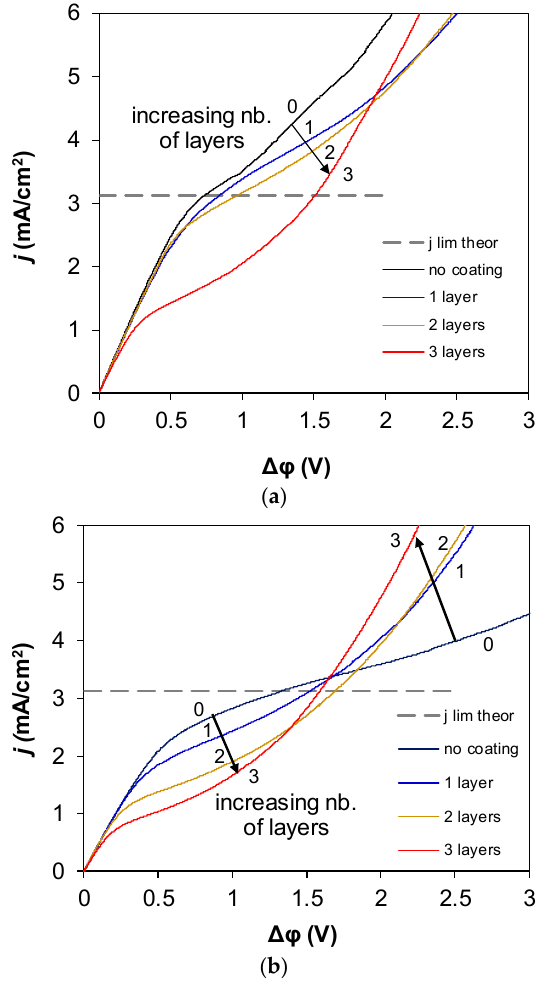
Figure 4. I–V curves of the homogeneous AMX-Sb membrane and its modifications ( a ) and the heterogeneous MA-41P membrane and its modifications ( b ). Arrows show the increased number of changes occurring with the additional layers of Nafion applied. The dashed line shows the theoretical limiting current calculated by the Lévêque equation. Numerals denote the number of applied layers ranging from zero (no coating, i.e., the commercial membrane) to three.